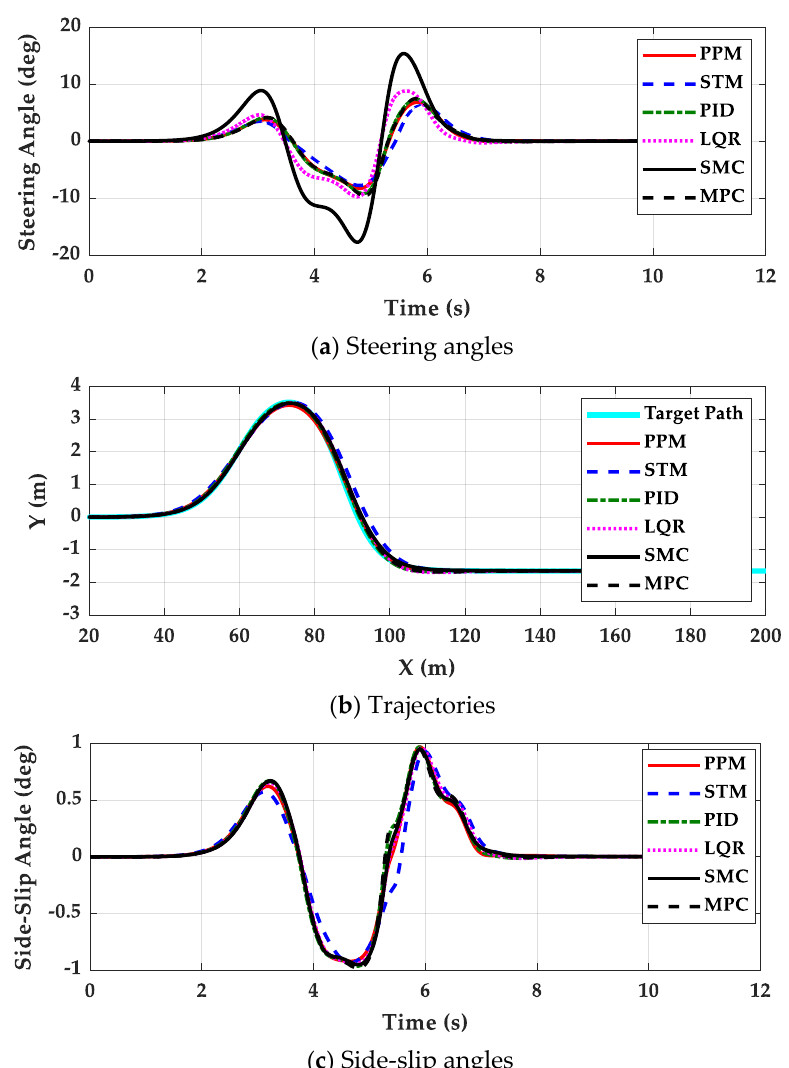
Figure 5. Simulation results of each controller for FWS vehicle on high- µ road obtained from the first set of simulations. Table 2. Summary of simulation results of each controller for FWS vehicle in the first set of simula- tions.